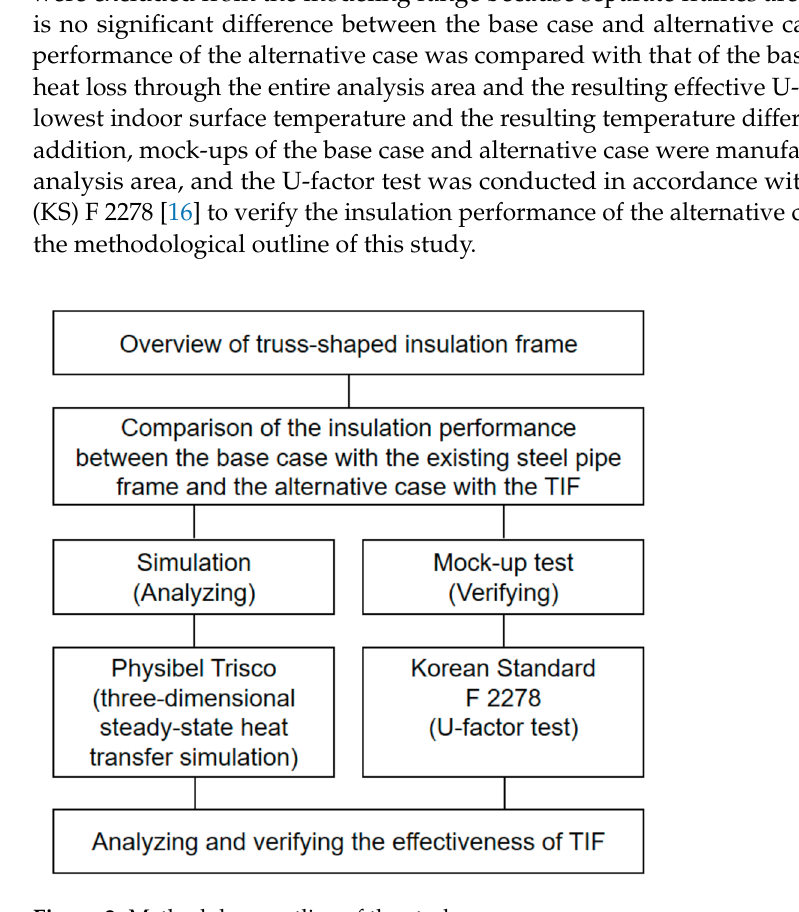
Figure 2. Methodology outline of the